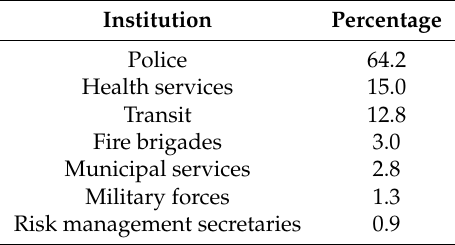
Table 1. Percentage of emergencies attended during 2014 by the first response institutions (FRIs) of the public safety answering point (PSAP) in Quito, Ecuador.